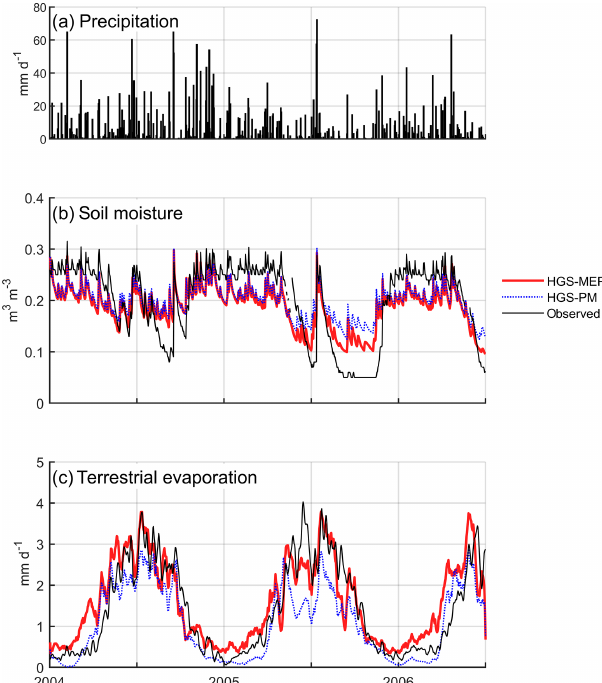
Figure 7. (a) Precipitation as well as observed and modelled (b) daily mean soil water content at a depth of 20cm, and (c) 10d moving average of terrestrial evaporation at US-WBW (climate: temperate; vegetation: deciduous broadleaf